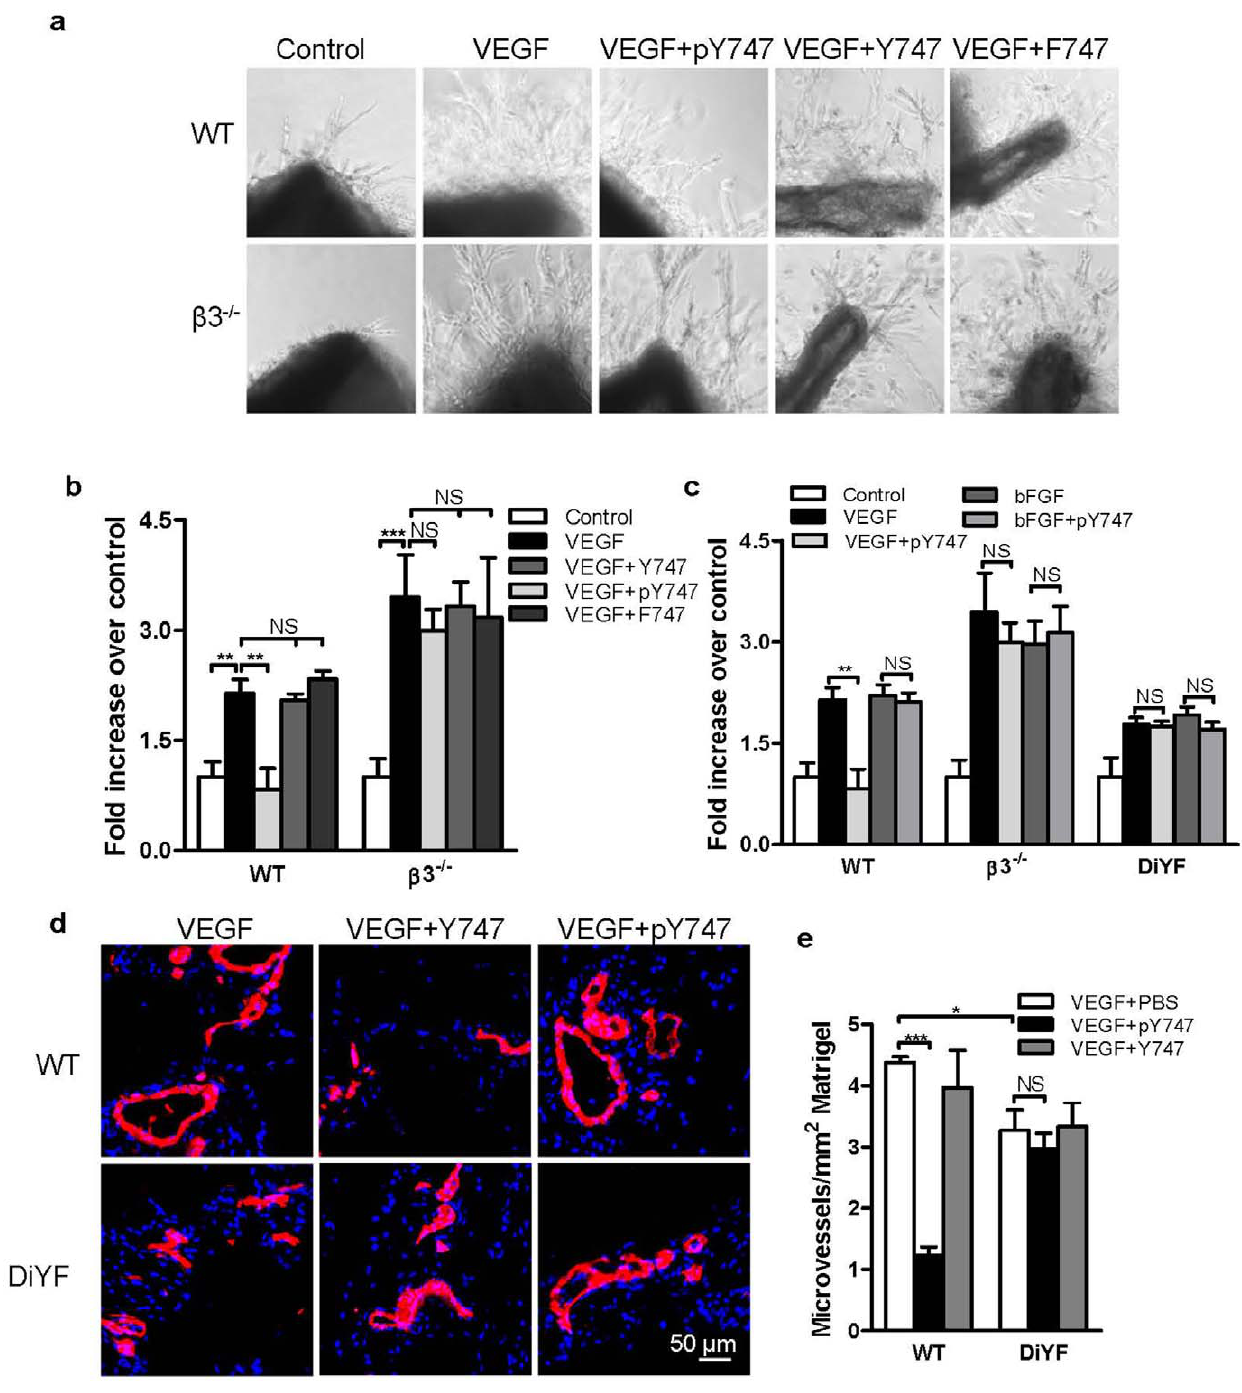
Figure 4. The pY747 peptide has no effect on b 3 2 / 2 or DiYF mice. a ) pY747 peptide does not inhibit VEGF-induced aortic ring growth from b 3 2 / 2 mice. Mouse aortic rings were embedded in matrigel in the presence of 40 ng/mL of VEGF and 40 m M of peptides as indicated. b ) Quantification of aortic ring assay as indicated in Fig. 4a. c ) pY747 could not inhibit bFGF-induced aortic ring growth, Mouse aortic rings were isolated from wild type (WT), b 3 2 / 2 , and DiYF mice and embedded in matrigel in the presence of 40 ng/mL of VEGF, 20 ng/mL of bFGF or pY747 peptides as indicated. Aortic rings were incubated for 3 days for wild type and b 3 2 / 2 aortic rings and 4 days for DiYF aortic rings (longer incubation was used to obtain visible aortic sprouting which is diminished in these mice). d ) pY747 peptide does not inhibit angiogenesis in DiYF mice. Peptides’ effect on in vivo angiogenesis in wild type mice and DiYF mice was tested as described. e ) Quantification of blood vessels in matrigel plus assay as indicated.